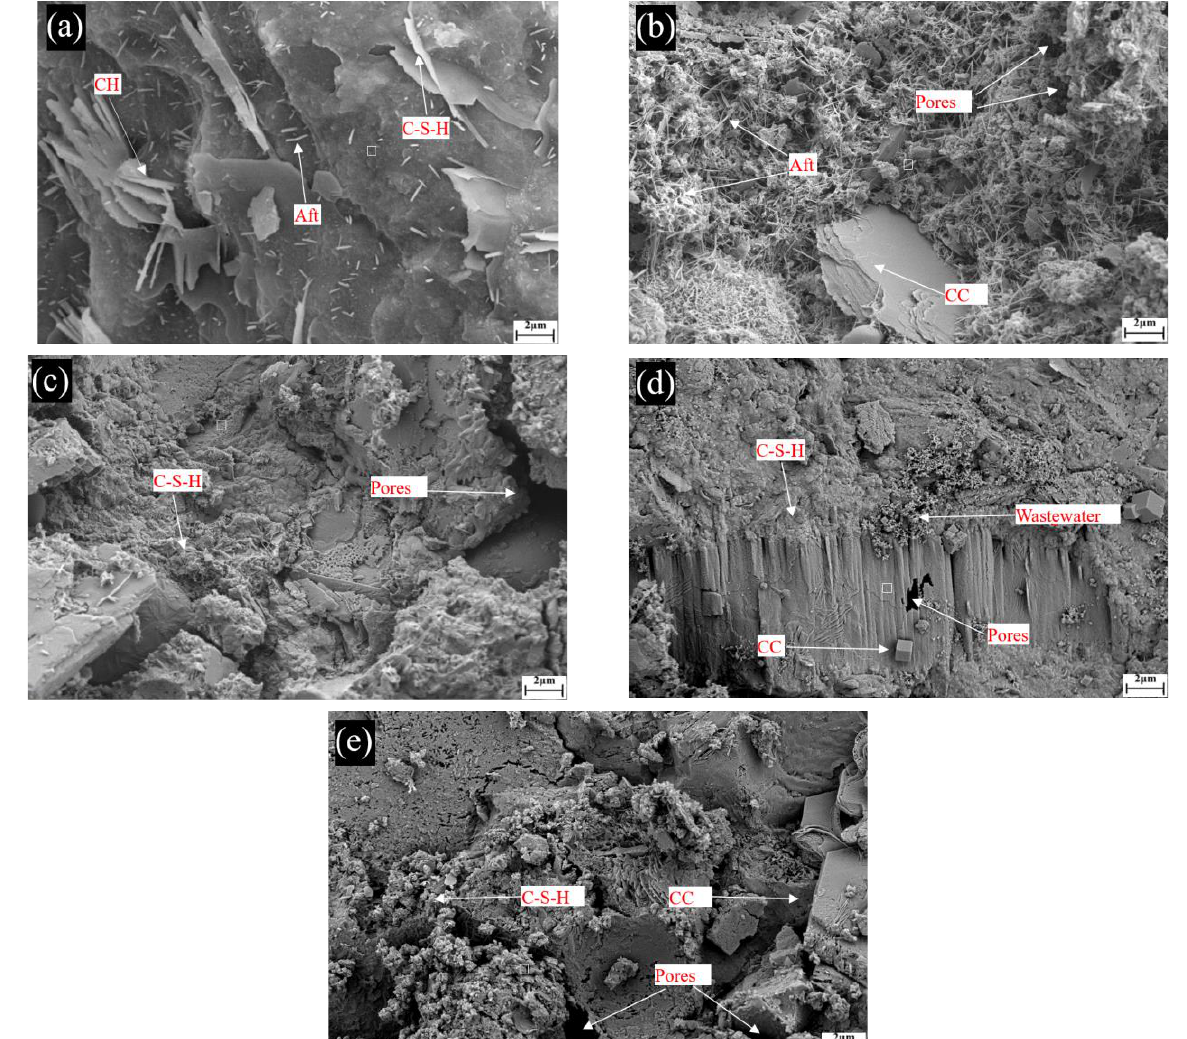
Figure 8. SEM image of C20 concrete at the age of 7 days. ( a ): C20-0; ( b ): C20-25; ( c ): C20-50; ( d ): C20-75; ( e ): C20-100. Aft = ettringite, C-S-H = calcium silicate hydrate, CH = Ca(OH) 2 , CC = CaCO 3 .